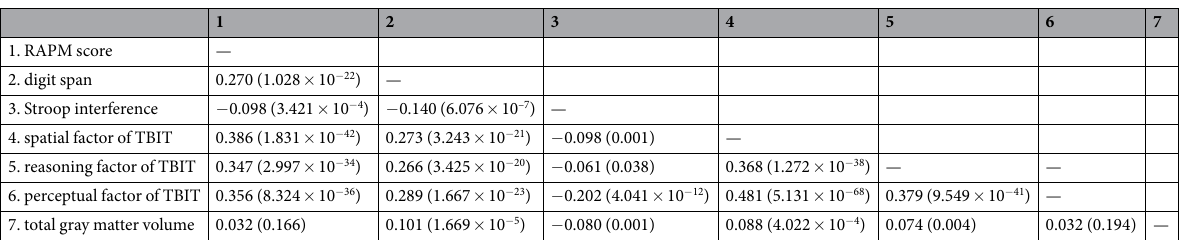
Table 2. Partial regression coefficients among cognitive tasks corrected for age and sex (in the case of Stroop interference, regression was corrected for control task performance in addition to age and